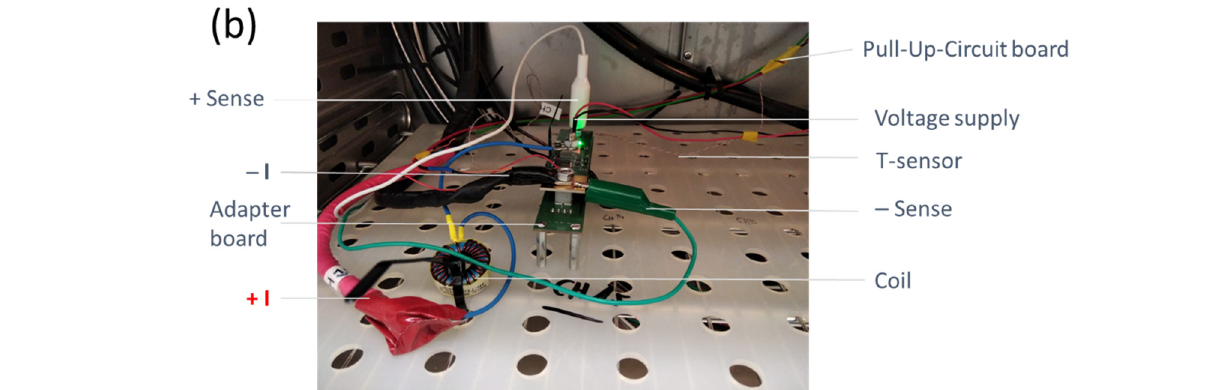
Figure 2. ( a ) Setup of the test device with the switching board and the connected test bench by means of the current and voltage sensors and an auxiliary board. ( b ) Picture of the test including switching board, coil, sensors and wiring.